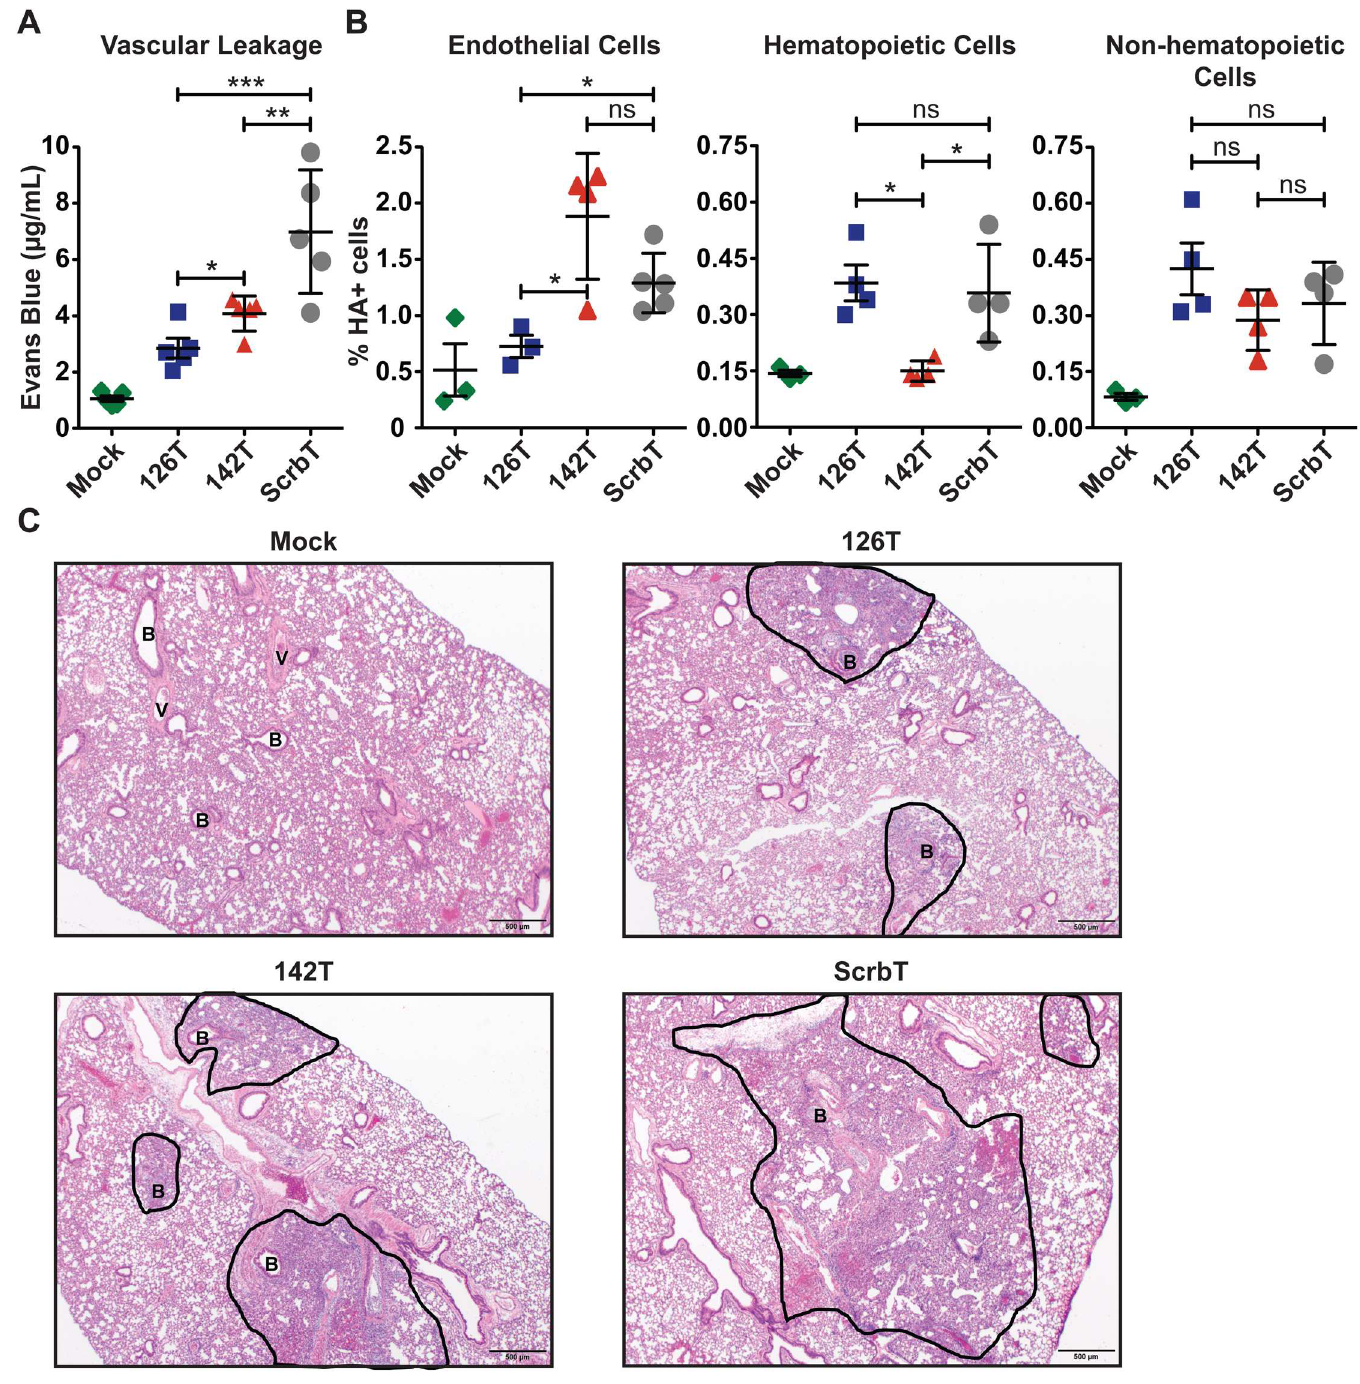
Fig 4. H5N1infection of endothelial cells increasesvascularleakage and causespronounced damage in the lungs. (A) Evaluationof vascular leakagein H5N1 infected lungs. C57BL/6Jmice (n = 5) were intranasally infected with 25 PFU of the H5N1viruses. On day 7 pi, Evans Blue dye was injected into mice via retro-orbitalroute. After 1h, mice were euthanized and the levels of Evans Blue dye in the BALF were measured.Each data point represents the concentration of Evans Blue dye in the BALF of individualmice (mean ± SEM). (B) Evaluationof infectionof variouscell populationsin vivo. C57BL/6Jmice (n = 3) were infected with 25 PFU of the H5N1 viruses. On day 3 pi, lungs were harvestedand analyzedfor H5N1 infectionof the variouscell compartments by flow cytometry. Cell surface markers CD45 and CD31 were used to distinguish endothelial cells (CD45 - , CD31 + ), hematopoietic cells (CD45 + ) and non- hematopoietic cells (CD45 - ), and surface expressionof viral HA was used to define infected cells (HA + ). Data is representedas the mean ( ± SEM). Asterisk denotesstatistical significancedeterminedby one-wayANOVA and the values are denotedas * p < 0.05, ** p < 0.01, *** p < 0.001and ns–nonsignificant.Data